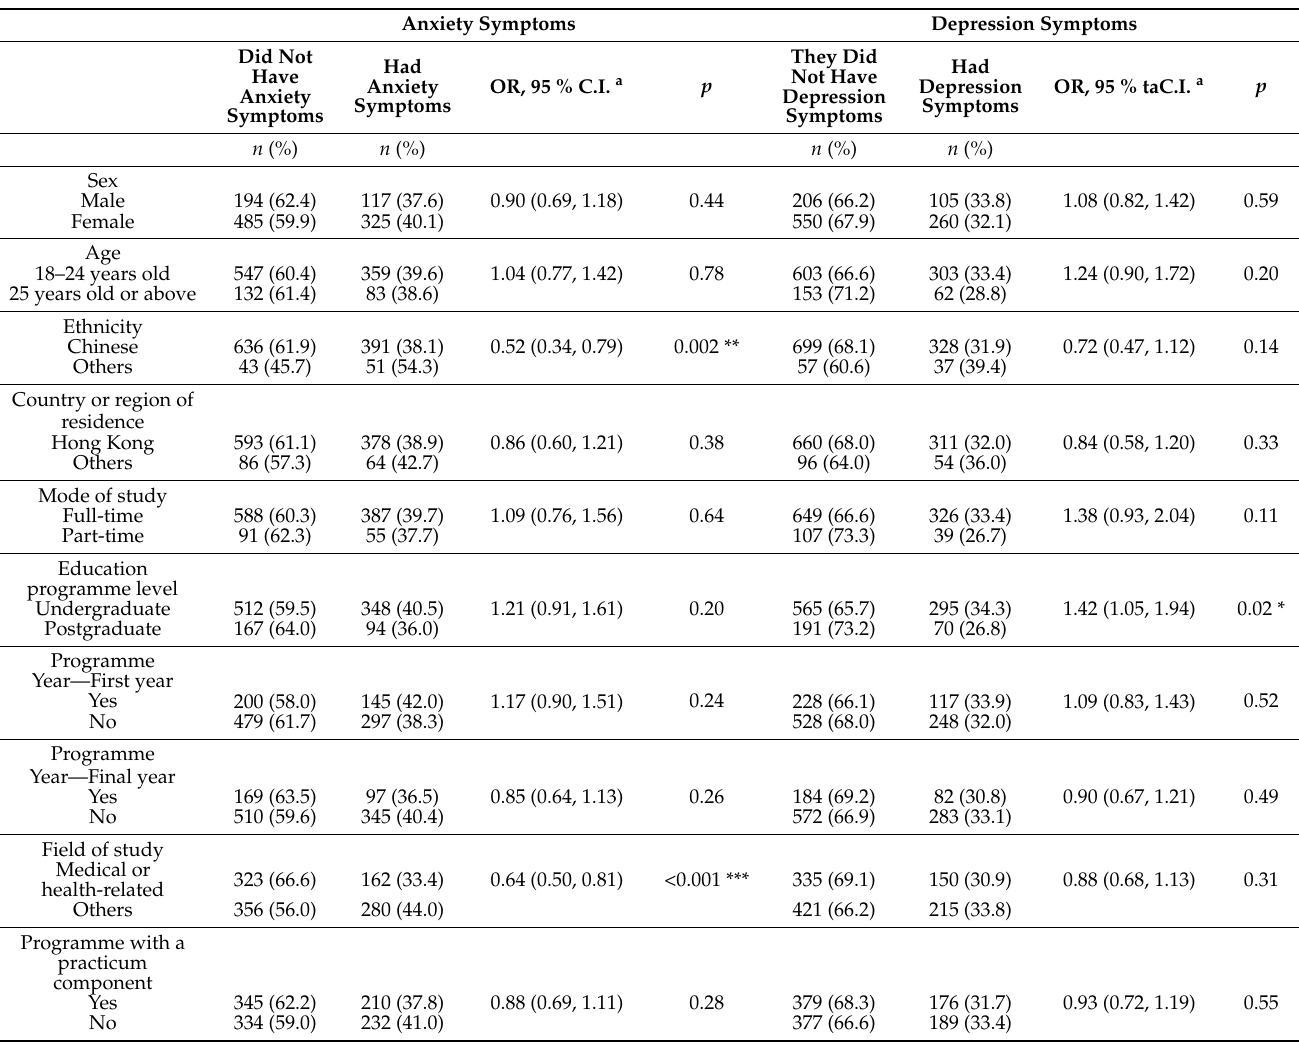
Table 2. Associations of students’ mental health with demographics and academic programme characteristics. Anxiety Symptoms Depression